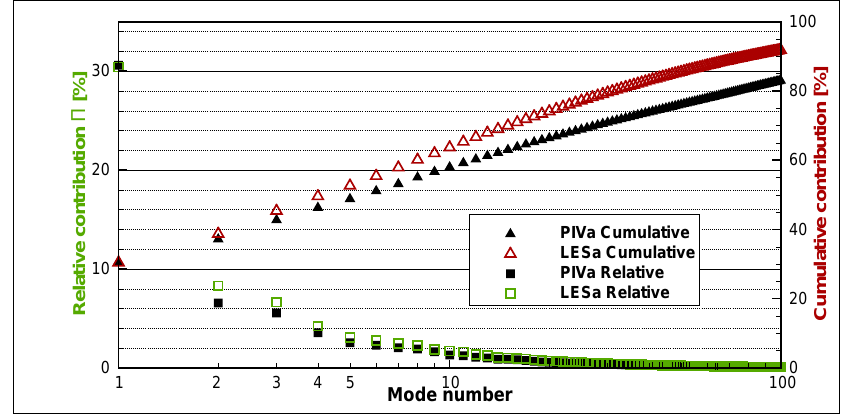
Figure 14. The comparison of the relative (squares) and cumulative (triangles) contributions of the first 100 individual POD modes of PIVa and LESa to the TKE